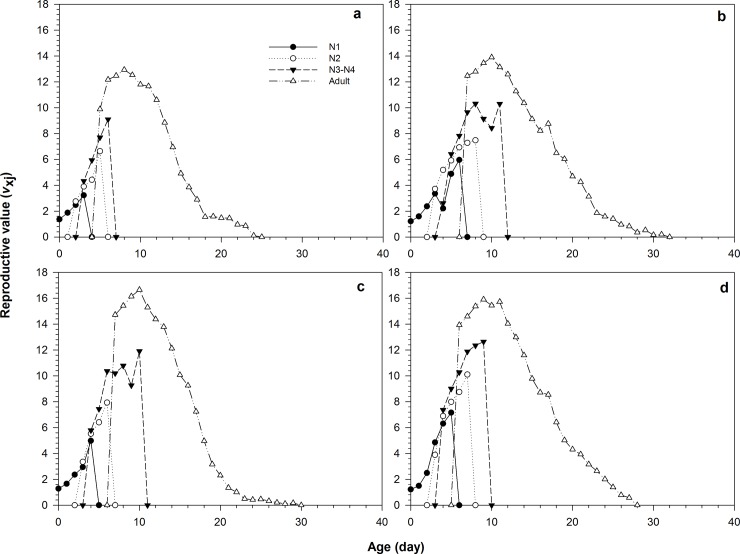
Age-stage-specific reproductive value (vxj) of Rhopalosiphum padi, the parental females of which were exposed to wheat leaves treated with different concentrations of imidacloprid.(a) Control, (b) LC10, (c) LC20, (d) LC25.